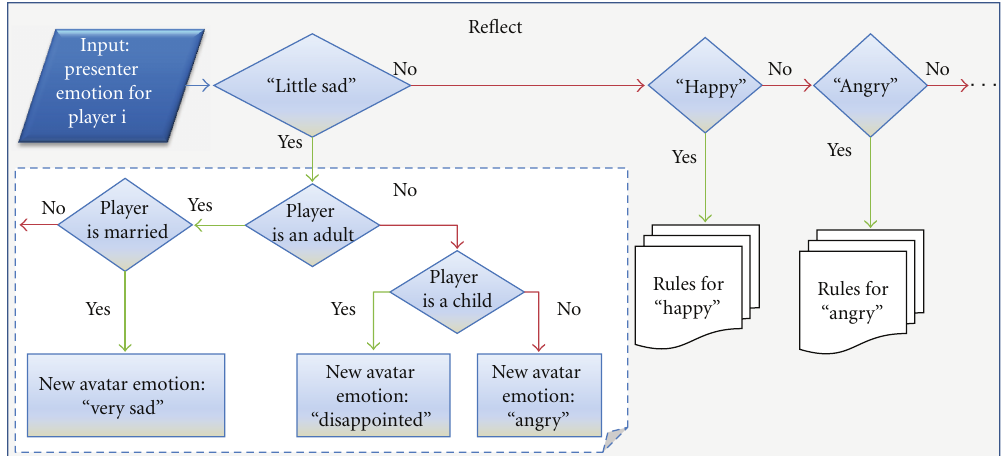
Figure 5: Emotion rules for “Big Score Loss.” The presenter was previously in a “Sad” emotional state because the player had lost a lot of scores. As player lost score again in this round, the presenter computes a new emotional state.